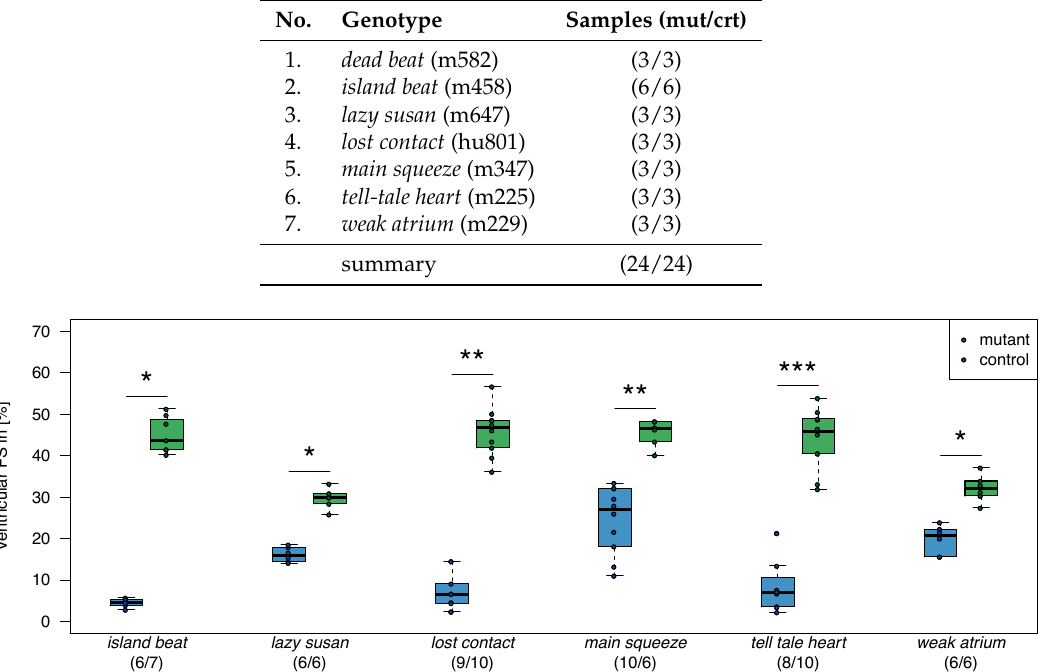
Figure 4. Ventricular fraction shortening of weak contractility/heart failure genotypes (zebrafish). For all genotypes, the differences between mutants and controls were tested ( n = 7, Wilcoxon-Rank-Sum tests, Bonferroni correction for multiple testing). Significance levels are indicated as *: p < 0.05, **: p < 0.01, ***: p <